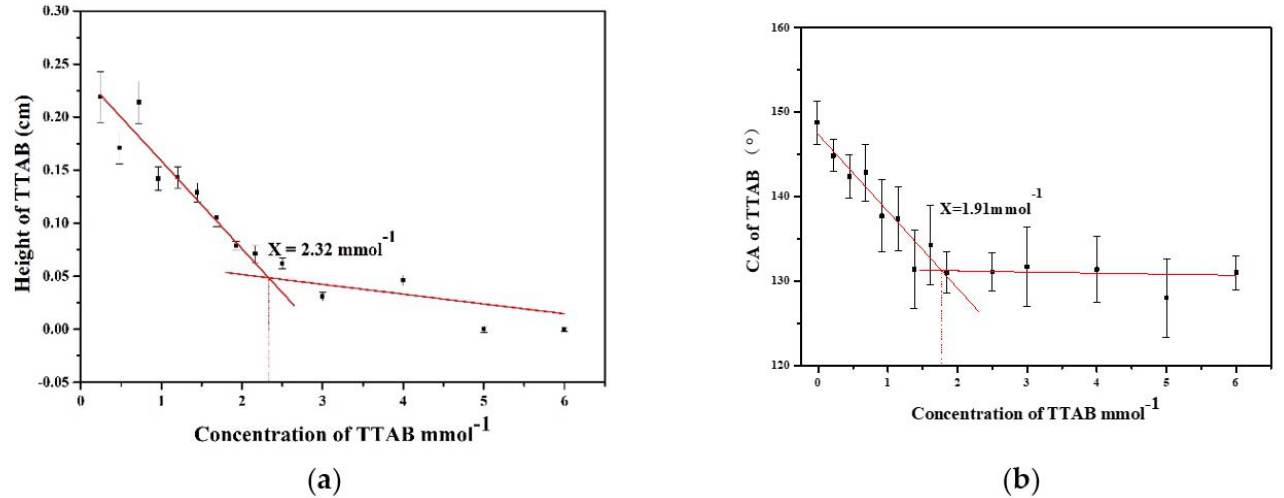
Figure 6. ( a ) The relationship between the first rebounding height on the superhydrophobic brass mesh and TTAB concentration. ( b ) The relationship between the values of the contact angle ( θ ) on the superhydrophobic mesh and TTAB concentration.